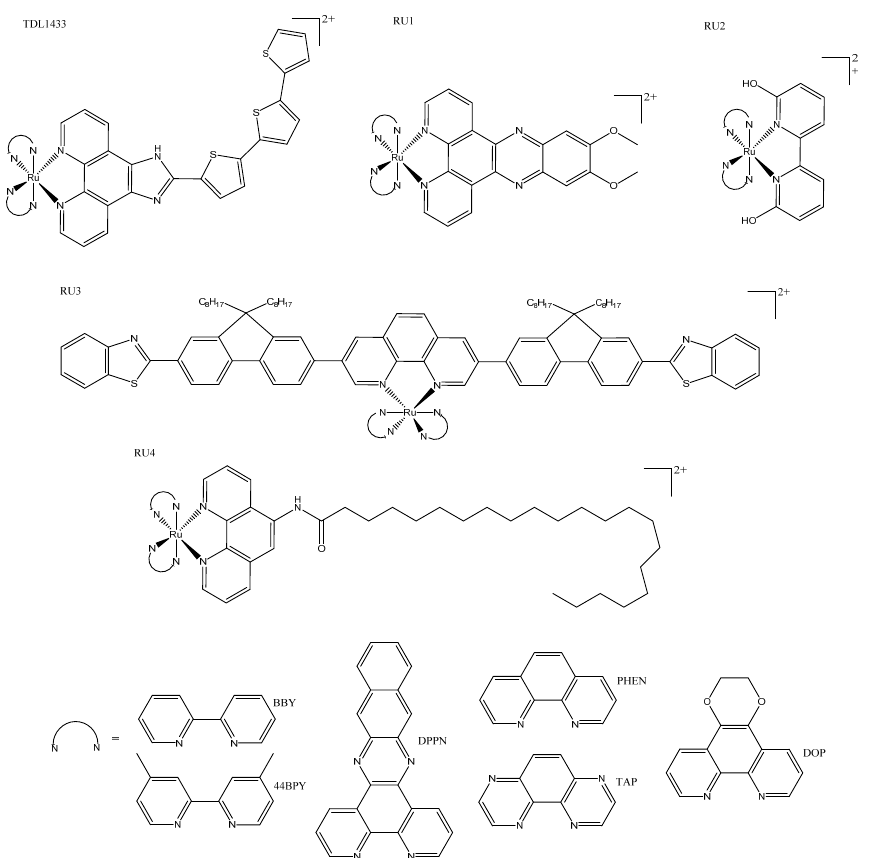
Figure 5. Tris(bipyridine)ruthenium(II)-inspired complexes: TDL1433, where N^N = 44BPY [50]; the similar complex RU1, where N^N = BPY [52]; complex RU2, where N^N = DOP [53]; heteroleptic Ru(II) complex RU3, where N^N = DPPN [54]; 21-carbon alkyl chain complexes RU4a and RU3b, where N^N = PHEN or TAP, respectively [55].